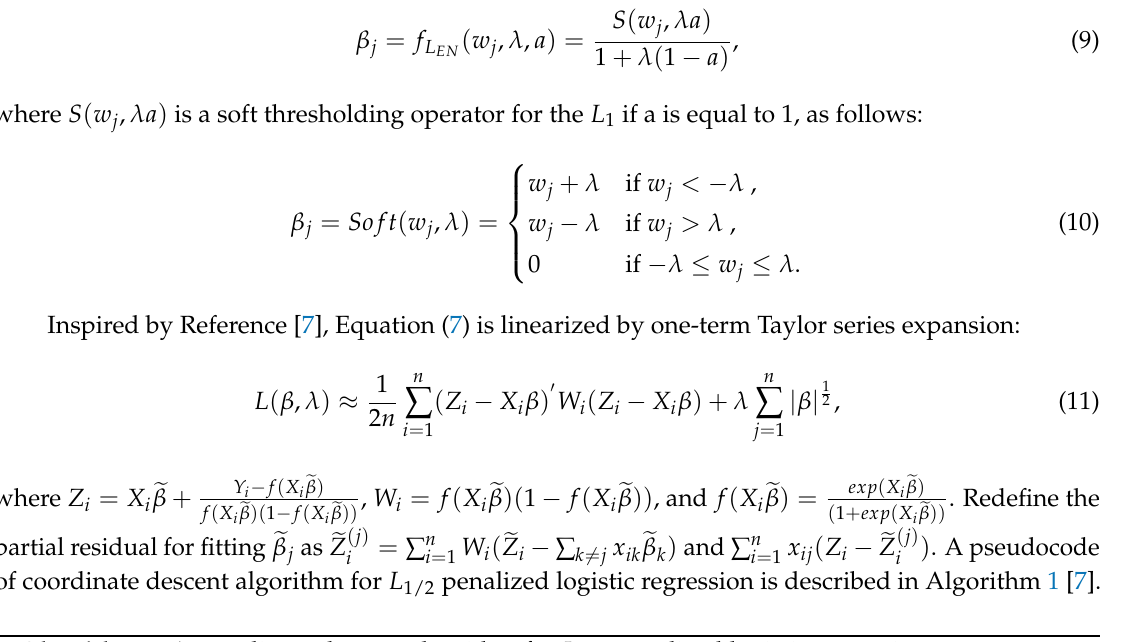
Algorithm 1: A coordinate descent algorithm for L 1/2 penalized logistic